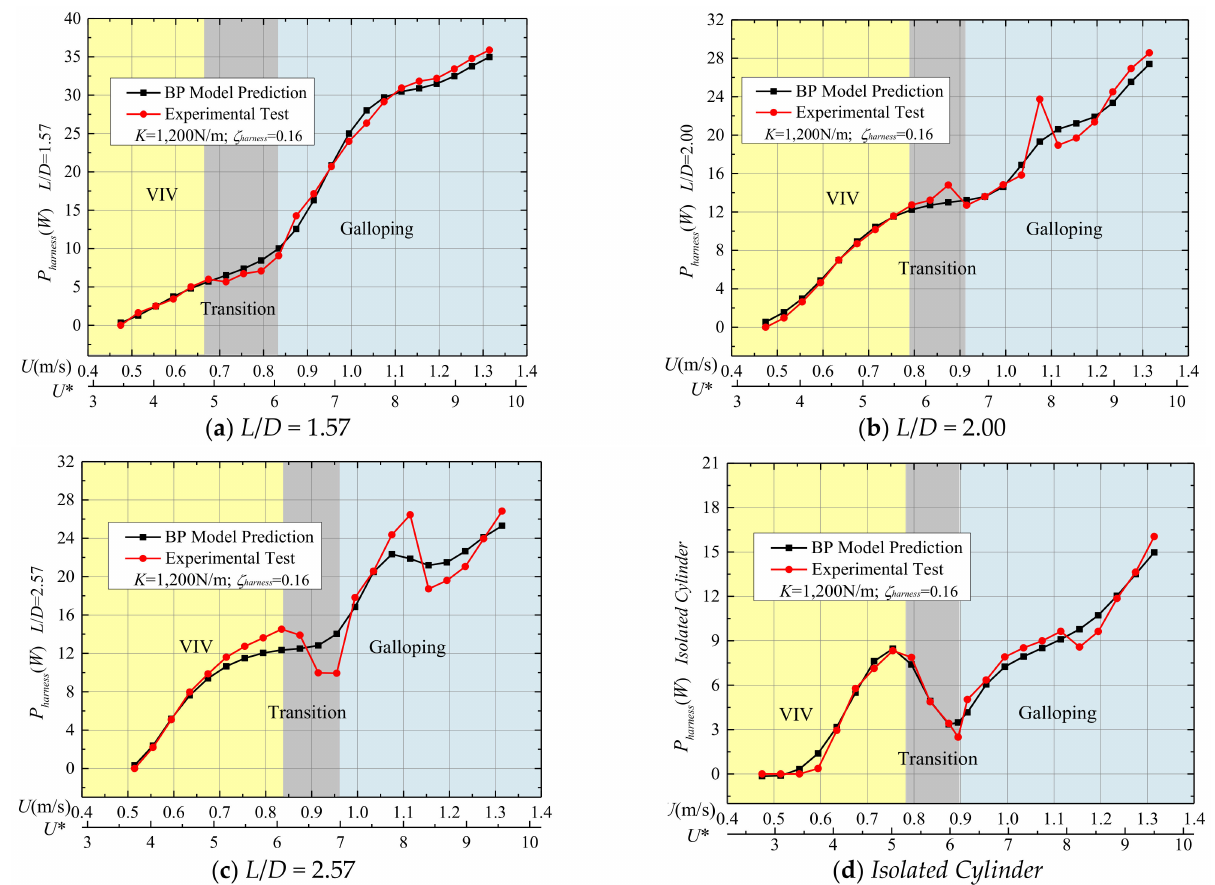
Figure 6. Comparison of P harness predicted numerically and measured experimentally: ( a ) L / D = 1.57; ( b ) L / D = 2.00; ( c ) L / D = 2.57; ( d ) Isolated